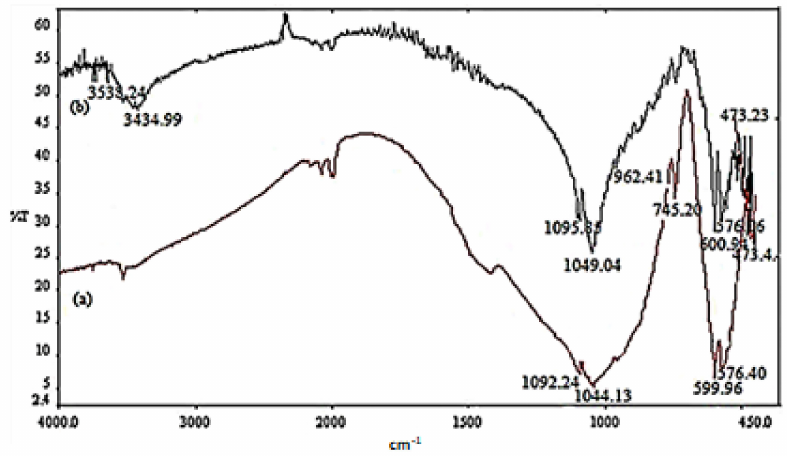
Figure 1. FT-IR spectra of: ( a ) NP, and ( b )